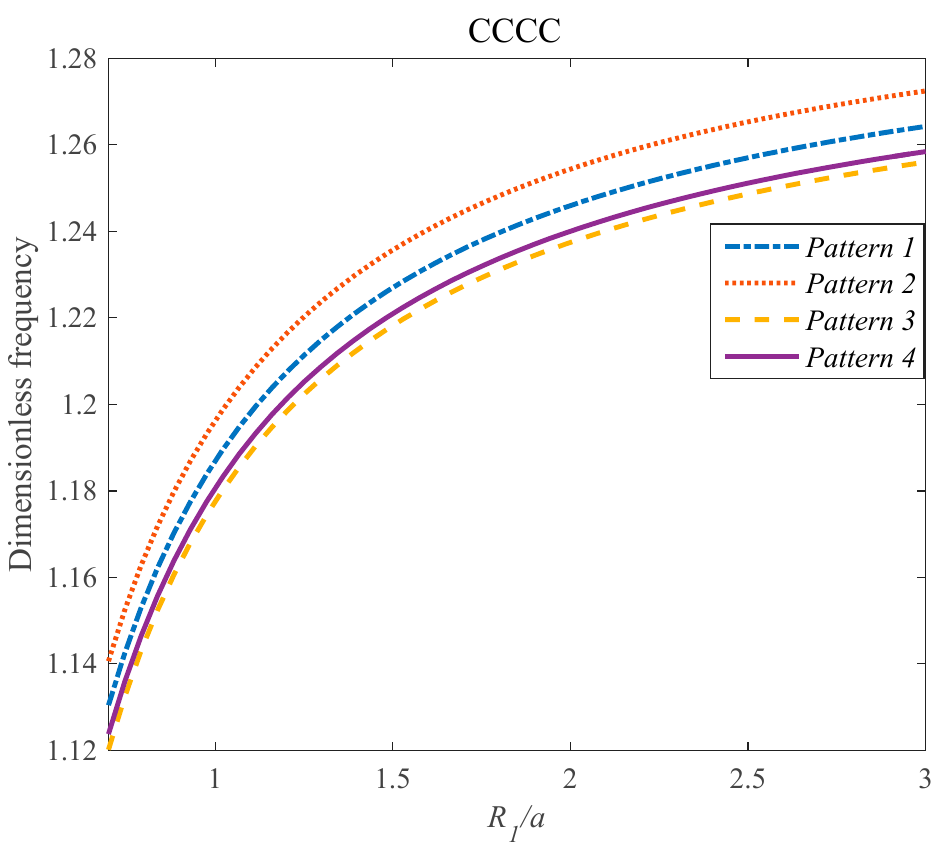
Figure 9. The effects of R 1 /a and GPLRC’s pattern on the frequency for the CCCC boundary conditions Figure 9. The e ff ects of R 1 / a and GPLRC’s pattern on the frequency for the CCCC boundary conditions (a/b = 5, h = b/10, R2 = 5a, ∆𝑇 (cid:3404) 100𝐾, 𝑔 (cid:3008)(cid:3017)(cid:3013) =0.5%, N L = 10, 𝜇 (cid:3404) ℎ/10, 𝑙 (cid:3404) ℎ/5 ). (a / b = 5, h = b / 10, R2 = 5a, ∆ T = 100 K , g GPL = 0.5%, N L = 10, µ = h /10, l = h